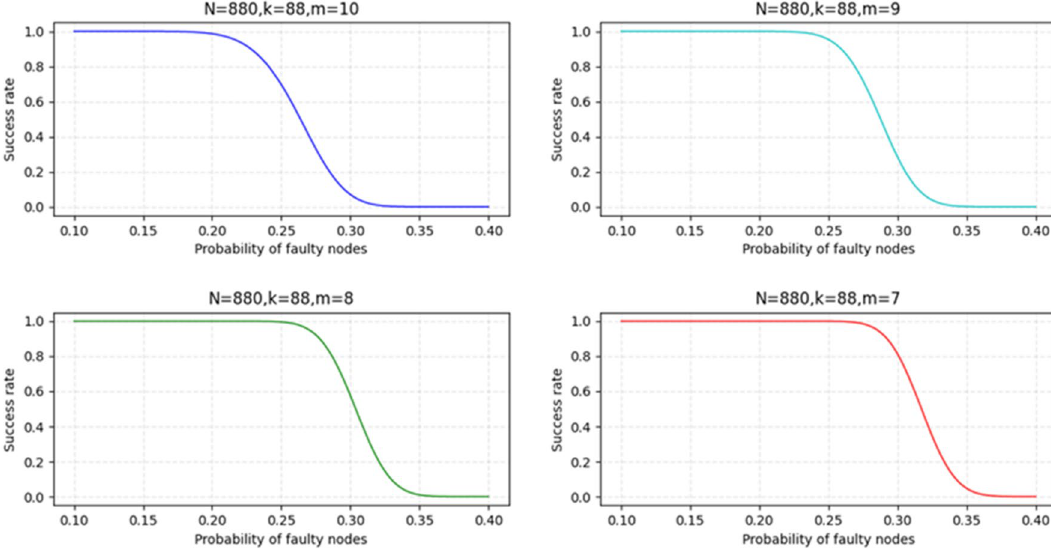
Figure 8. Analysis results of the relationship between success rate and P F under different m and the same K and